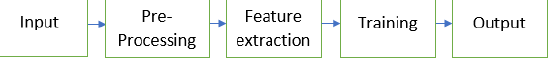
Figure 3:Traditional image recognition methods